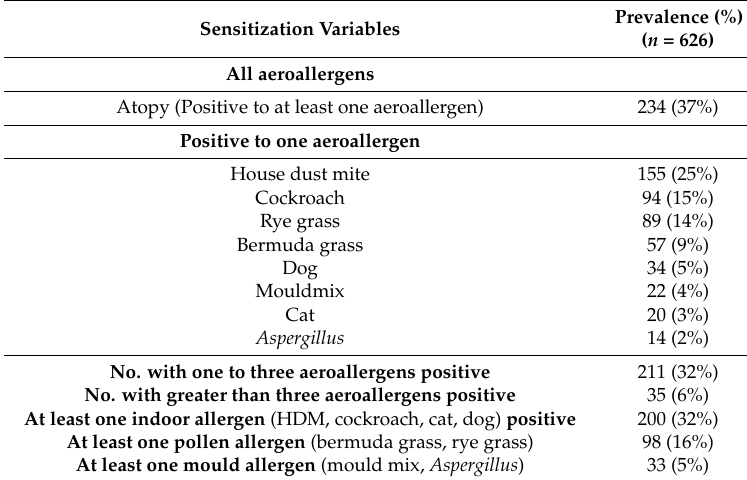
Table 2. Allergic sensitization profiles of seafood processing workers along the West Coast of the Western